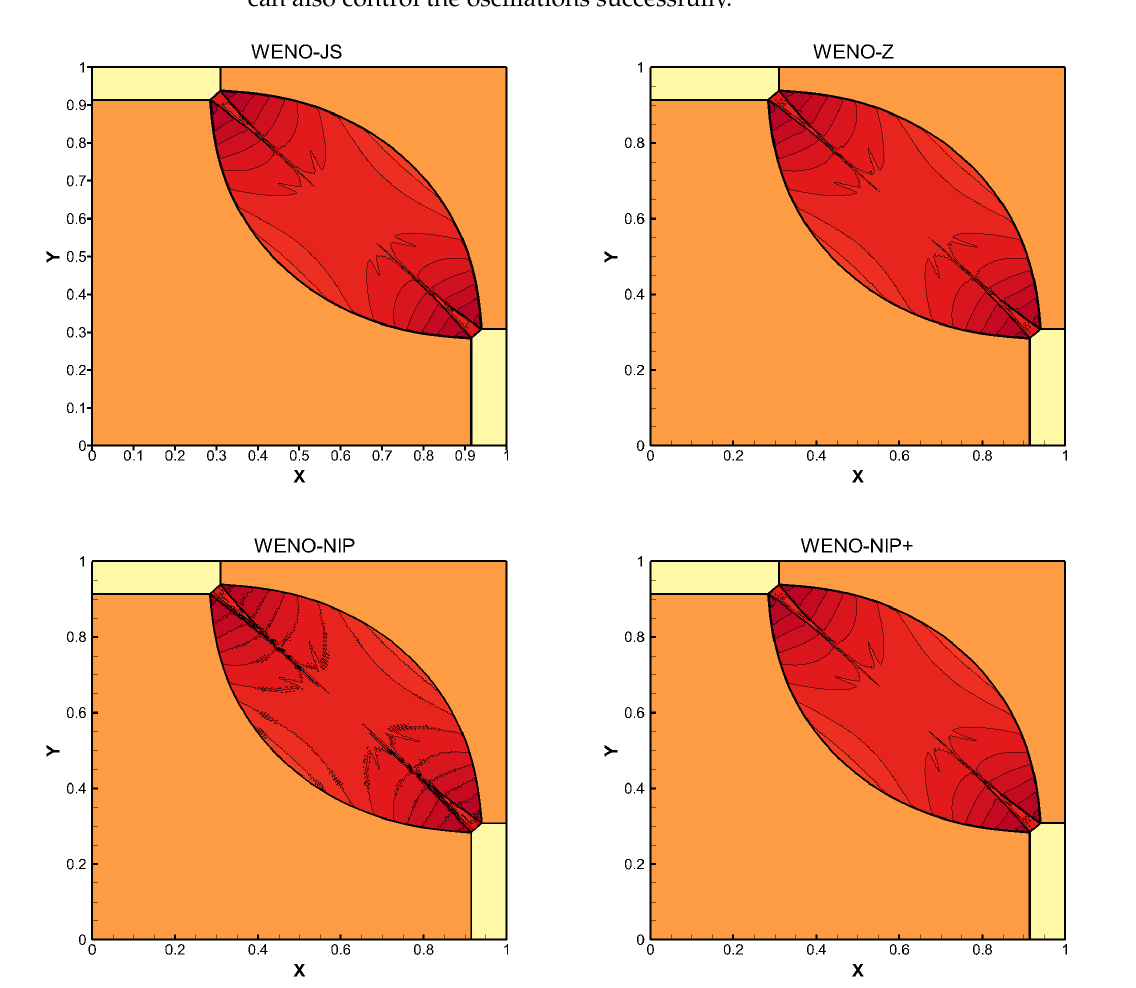
Figure 22. Numerical solutions of the 2D Riemann problem using 800 × 800 cells at t = 0.25. Left upper corner, WENO-JS. Right upper corner, WENO-Z. Left lower corner, WENO-NIP. Right lower corner,